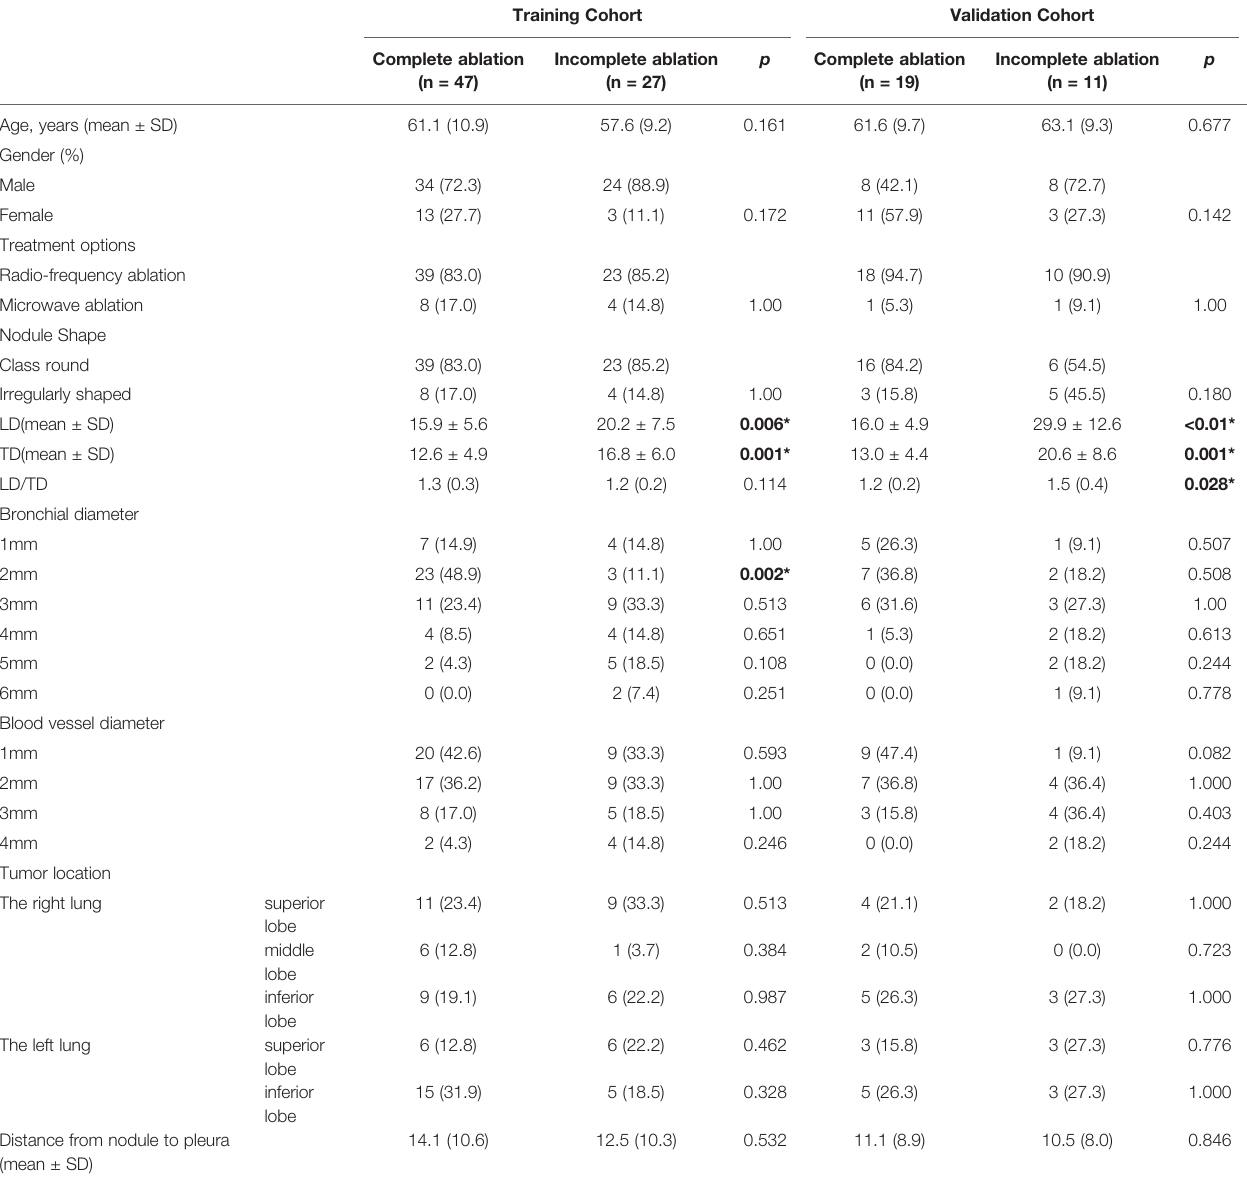
TABLE 1 | Characteristics of patients in the training and validation